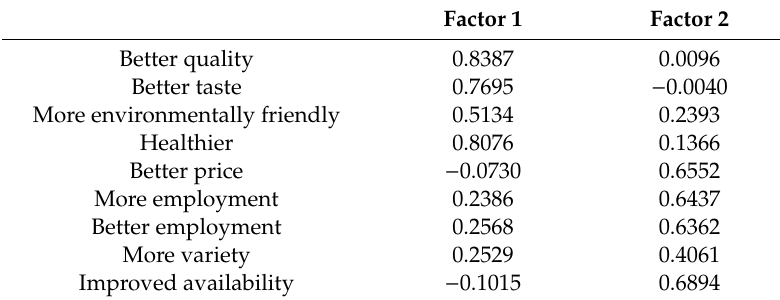
Table 9. Factor loads after Varimax rotation.